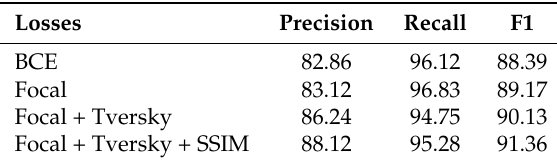
Table 3. Ablation study on hybrid loss of BA 2